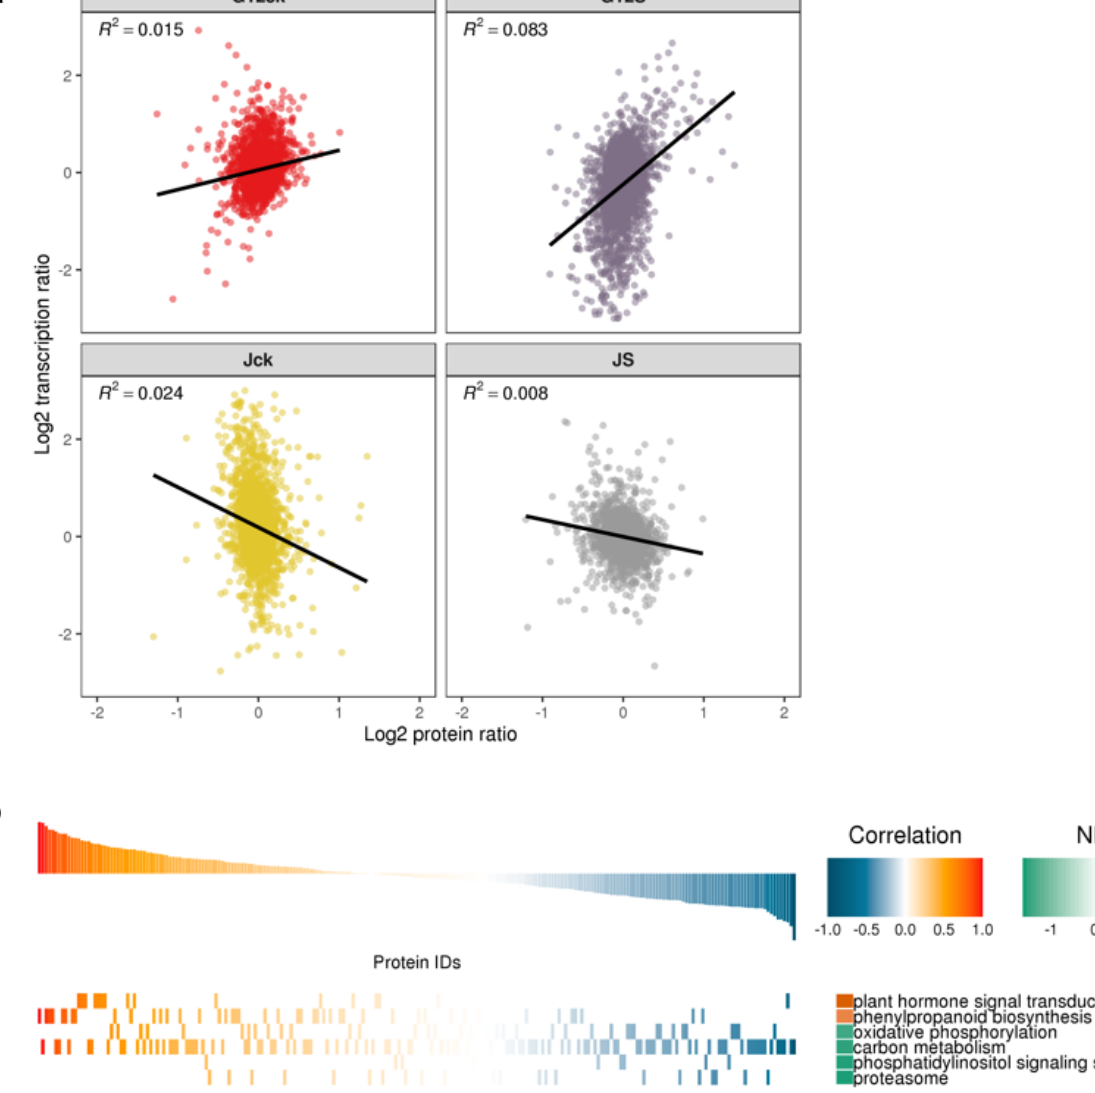
Figure 6. Combined analysis of proteome and transcriptome. ( A ) Scatter plot of transcripts and their corresponding proteins. ( B ) GSEA analysis of KEGG pathway based on quantitative correlation coefficients of transcriptome and proteome.